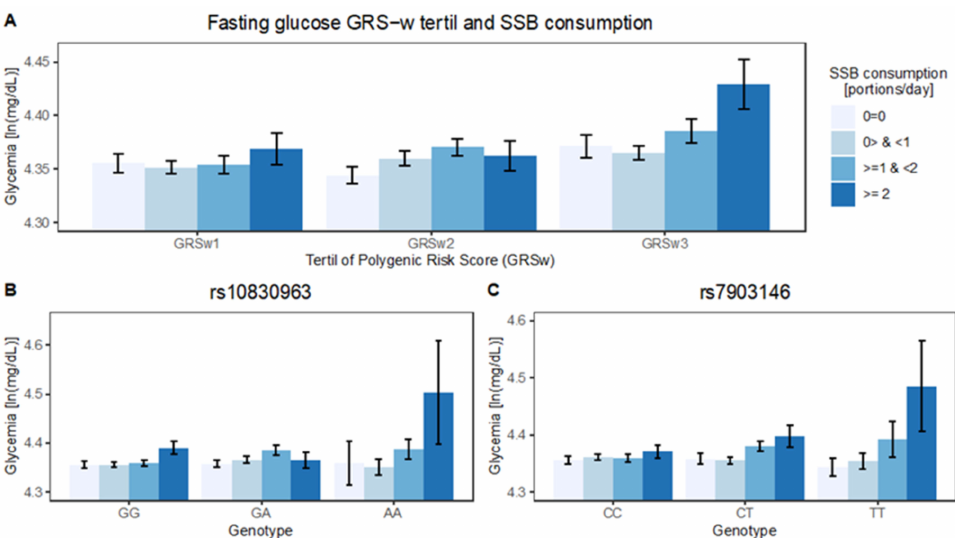
Figure 2. Fasting glucose association with SSB is dependent on genetic risk for T2D. Average log- fasting glycemia is plotted SSB category against tertiles of GRSw ( A ) and genotypes of rs10830963 (MTNR1B) ( B ) and rs7903146 (TCF7L2) ( C ), n =